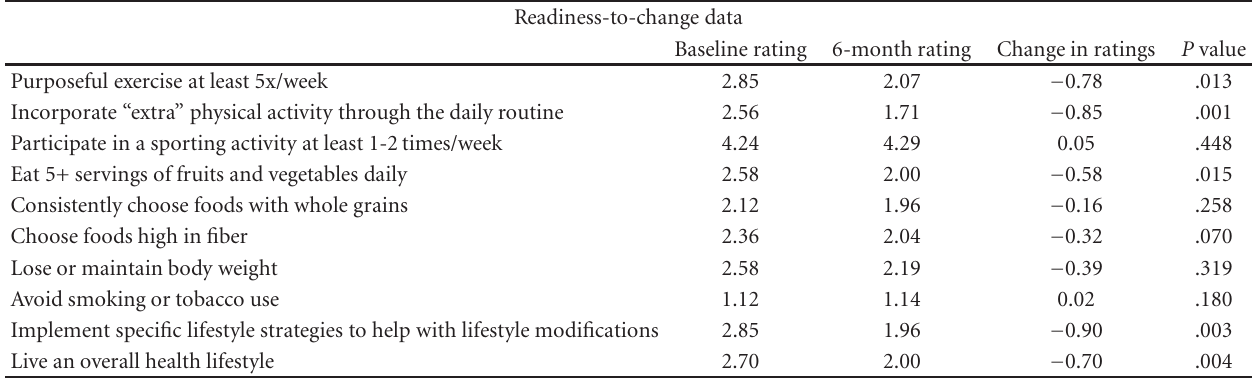
Table 1: Readiness-to-change lifestyle